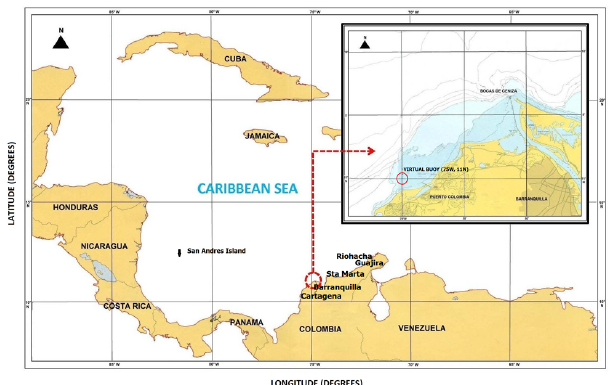
Fig. 4. Caribbean Sea (Source: CIOH-DIMAR).